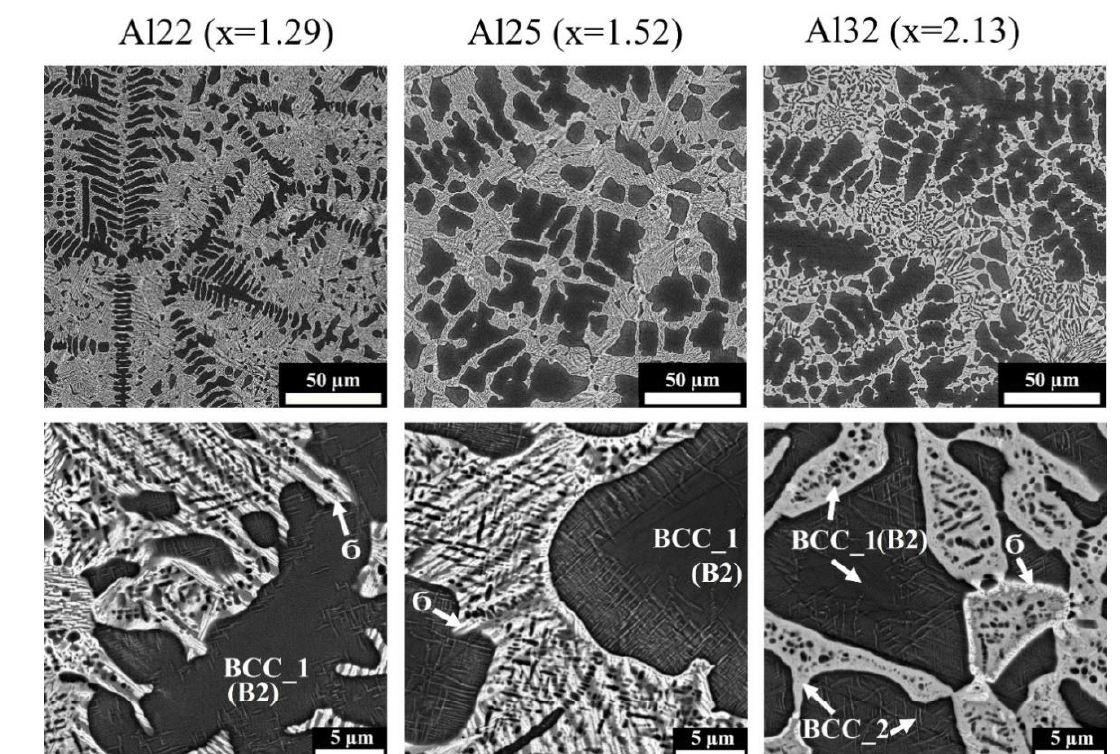
Figure 4. SEM microphotographs of the Al22, Al25, and Al32 alloys. σ -phase — the lightest, BCC_1(B2) — the darkest, and BCC_2 — grey structural components.